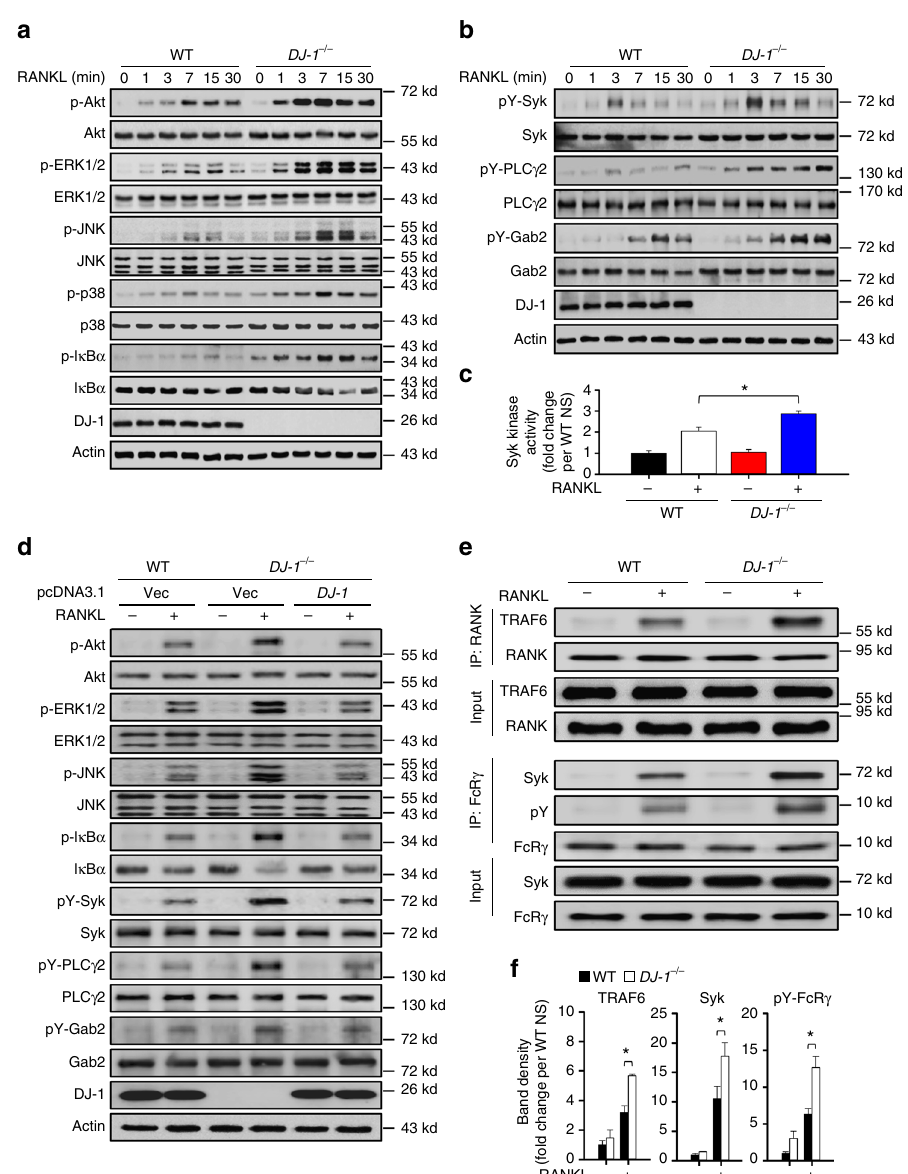
Fig. 3 DJ-1 is critical to TRAF6 and ITAM-mediated signals. a , b Representative immunoblot images for RANKL-stimulated signals in WT or DJ-1 − / − BMMs. c Syk kinase activity in WT or DJ-1 − / − BMMs. * p < 0.05 vs. RANKL stimulated WT BMMs by Student ’ s t -test. d Representative immunoblot images for RANKL- stimulated signaling proteins in WT, or DJ-1 − / − BMMs with or without overexpression of DJ-1 plasmid. e Representative images for co-immunoprecipitation of TRAF6 and RANK or FcR γ and Syk in WT or DJ-1 − / − BMMs. f Band density of the associations in e . * p < 0.05 vs. RANKL stimulated WT BMMs by Student ’ s t - test. Representative images a , b , d , e and data c , f shown as the mean ± s.e.m. from three independent experiments in